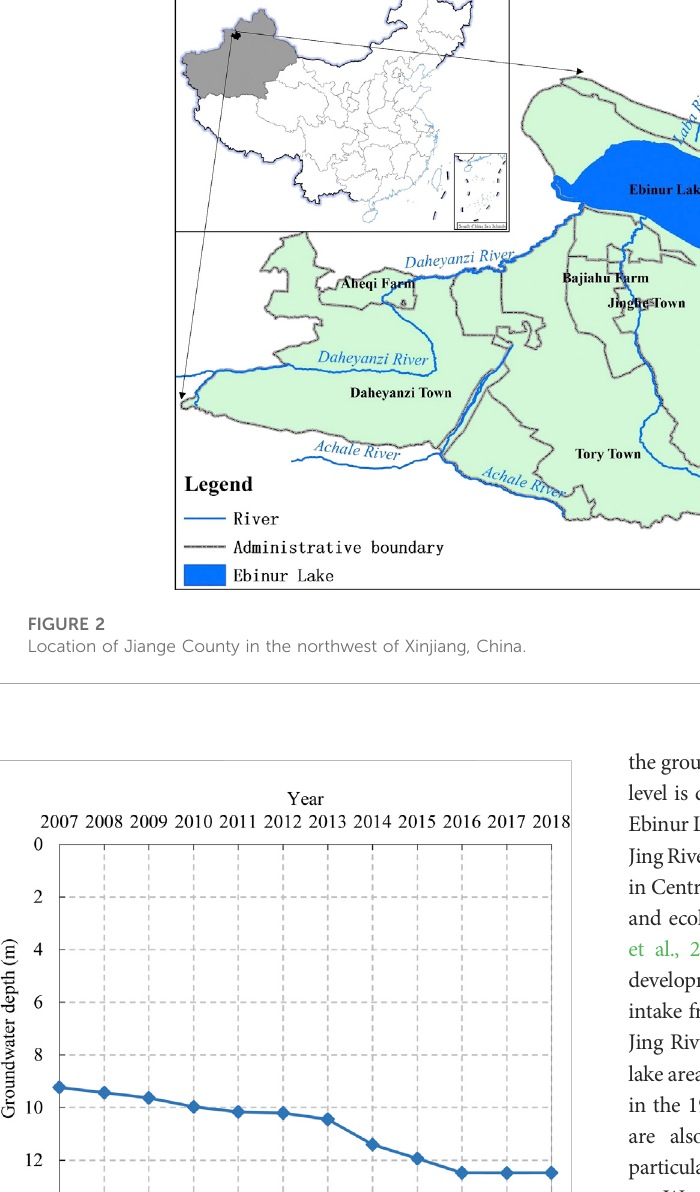
FIGURE 3 Decline of groundwater level by about 3.24 m from 2007 to